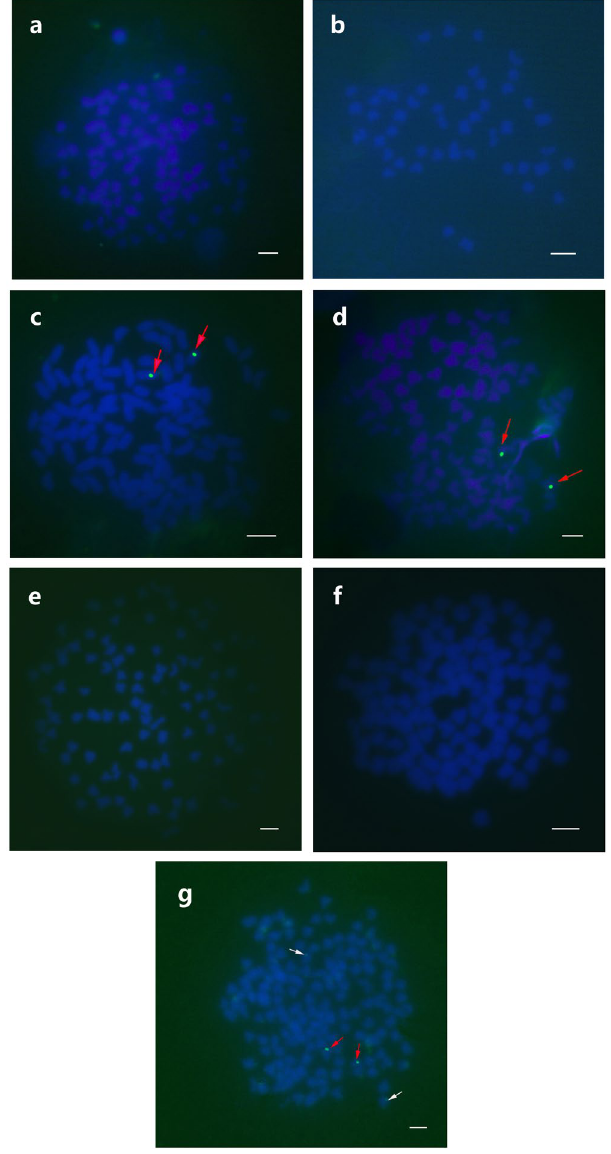
Figure 2. Examination of FISH signals in 2nCOC, 2nBSB, 2nNCRC, 2nNCRC-F 2 , 2nGCOC, 2nGMCC and 4nCB. ( a ) 2nCOC does not have a 5S gene locus. ( b ) 2nBSB does not have a 5S gene locus. ( c ) 2nNCRC has two strong fluorescence signals (red arrows). ( d ) 2nNCRC-F 2 has two strong fluorescence signals (red arrows). ( e ) 2nGCOC does not have a 5S gene locus. ( f ) 2nGMCC does not have a 5S gene locus. ( g ) 4nCB has two strong (red arrows) and two weak (white arrows) fluorescence signals. Scale bars in a–g, 3 μ